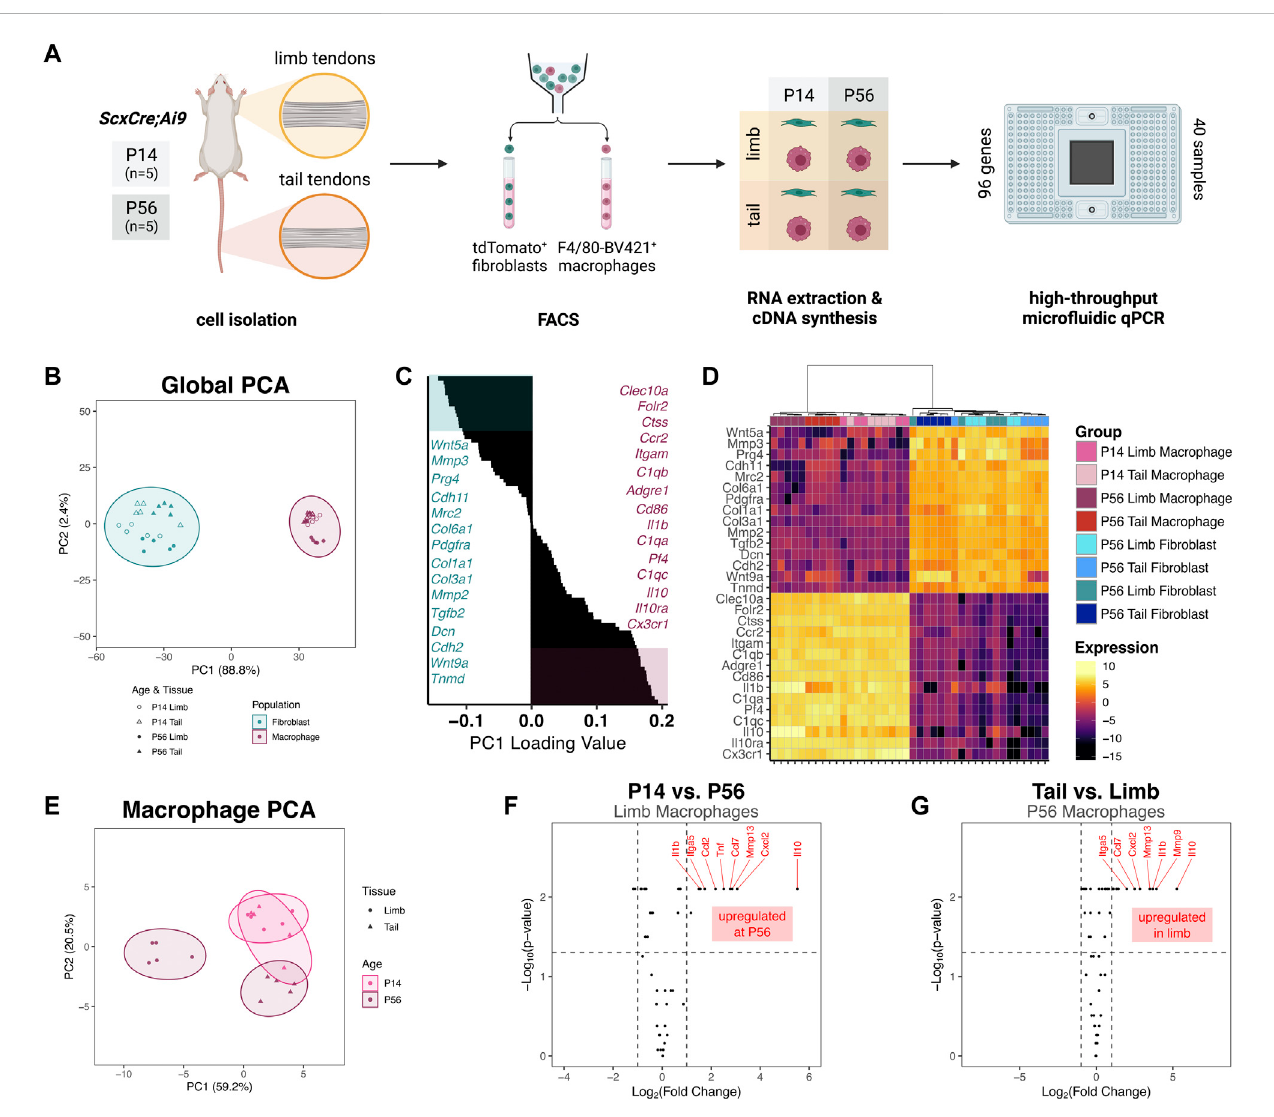
FIGURE 4 Gene expression pro fi les of tendon resident macrophages varies by source tendon and age (A) Experimental design for FACS and gene expression assay. Cells wereisolatedfromlimbtendonsandtailtendonscollectedfromP14andP56ScxCre;Ai9mice( n =5samplespertissuepertimepoint).Cellsuspensionswerestained with anti-F4/80-Brilliant Violet 421 and subjected to FACS to obtain tdTomato + fi broblasts and F4/80-Brilliant Violet 421 + (F4/80-BV421 + ) macrophages. RNA was extractedfromeachof40sortedcellsuspensionsandconvertedtocDNA.The40uniquecDNAsampleswerepreampli fi edthenloadedinduplicate(80samples total)ontoaFluidigmmicro fl uidicqPCRchipalongwith96TaqManGeneExpressionAssays (B) PC1scorevsPC2scorefromPCAofallsamplesandgenes.Prediction ellipsesrepresent95%con fi denceintervals (C) WaterfallplotofPC1loadingvalueswithtop15(teal)andbottom15(maroon)geneshighlighted (D) Heatmapofgenes withhighest15andlowest15PC1loadingvalueswithhierarchicalclustering.GeneswithPC1loadingvalues > 0wereselectedforsubsequentmacrophage-onlyPCA (E) PC1 score vs PC2 score from PCA of macrophage groups only (F) Volcano plot comparing P56 limb tendon macrophage vs P14 limb tendon macrophage gene expression. Horizontal dotted line indicates p = 0.05 threshold; left vertical dotted line indicates fold change of − 1; right vertical line indicates fold change of 1 (G) Volcano plot comparing P56 limb tendon macrophage vs P56 tail tendon macrophage gene